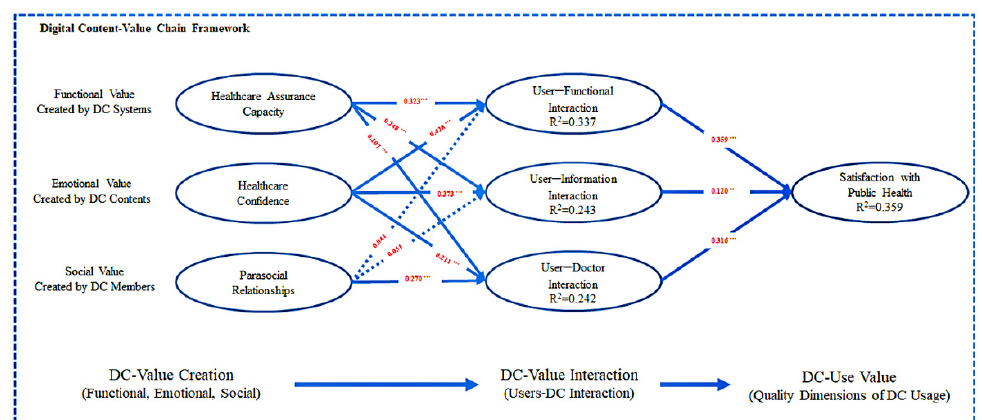
Figure 4. Test results of the structural model test. Note: *** p < 0.001 and ** p < 0.05. Table 6. Hypothesis testing